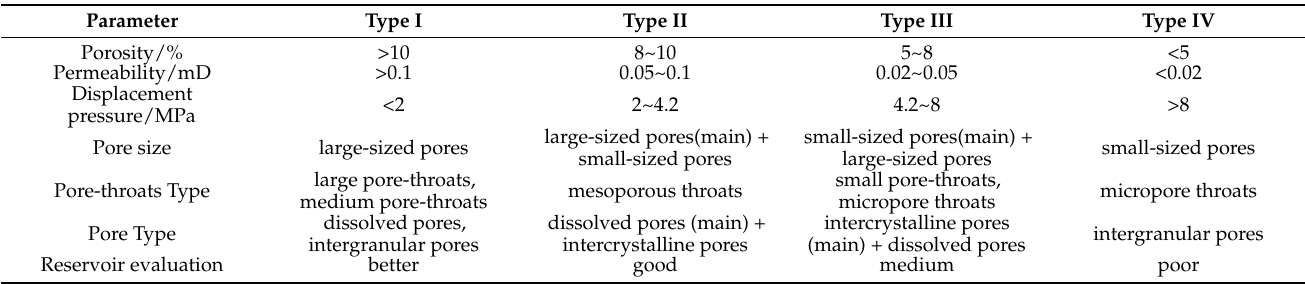
Table 1. Classification and evaluation scheme of shale oil reservoirs in the 7 1-2 sub-member of the Longdong